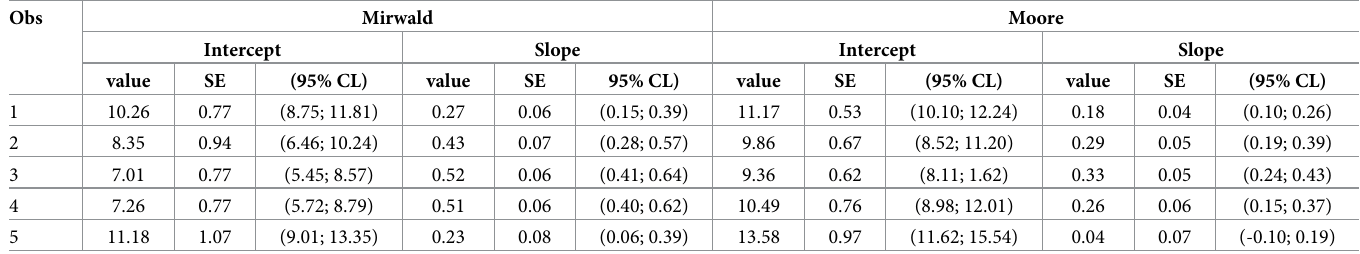
observations. Predicted maturity offset with the Mirwald equation is less than actual offset and predicted offset with the Moore equation across the five observations. Corresponding trends in predicted ages at PHV and the difference of predicted minus observed ages at PHV parallel those for maturity offset. Standard deviations for predicted maturity offset and ages at PHV with both equations are consistently lower than correspond- ing standard deviations for observed offset and age at PHV across the five observations. Vari- ability is reduced more so with the Moore compared to the Mirwald equation. Results of the mixed effects model indicate significant differences between observed and predicted ages at PHV with the Mirwald equation (F = 40.95; p < 0.001) and also with the Moore equation (F = 9.39; p < 0.01). Details of the analytical protocol and results are summa- rized in S1 Table. The differences between observed and predicted ages at PHV with the respective equations at each observation increase significantly with subsequent observations with the Mirwald (F = 22.81; p < 0.001) and the Moore (F = 172.97; p < 0.001) equations, although the 95% confidence intervals indicate that the difference at observation 1 for the Moore equation is not different from zero. Intercepts based on weighted Deming regressions for the two prediction equations are well above zero at each observation, indicating that the methods differ significantly by a constant error (Table 2). Estimated slopes for each regression are < 1.0, indicating significant propor- tional differences between predicted ages at PHV with each equation and observed age at PHV. Overall, the results indicate systematic error for predicted ages at PHV. Table 2. Intercepts and slopes, and respective standard errors (SE) and 95% confidence limits based on the weighted Deming regression of predicted ages at PHV (y-axis) and observed (actual) ages at PHV (x-axis) for the Mirwald and Moore prediction equations at each observation (Obs) in youth soccer players � . Obs Mirwald Moore Intercept Slope Intercept Slope value